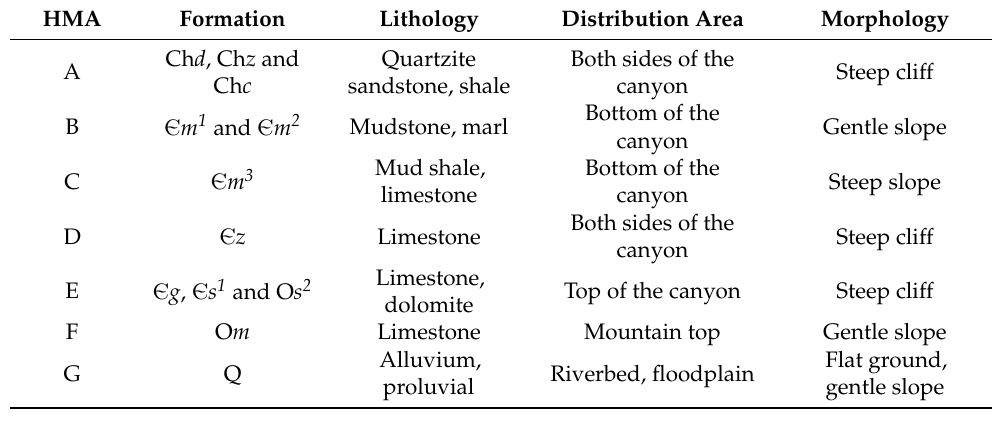
Table 4. Classification scheme of the main HMAs in the study area.